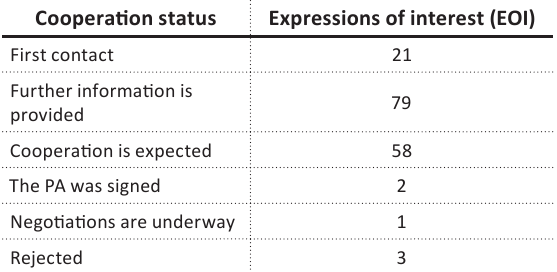
Table 4. Analysis of cooperation by type of profile “R&D request” in the context of Ukraine for the first half of 2019